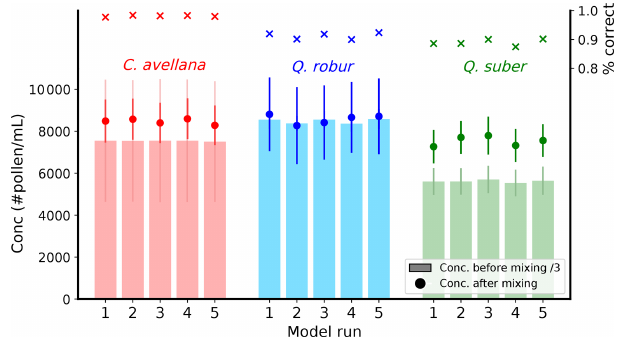
Figure 6. Quantification of pollen concentrations in single-type samples and in a mixed sample. The model was deployed to clas- sify and quantify pollen concentrations in three samples contain- ing purely C. avellana (red), Q. robur (blue), and Q. suber (green) pollen. The percentages of correct predictions among the three pollen classes are indicated in the top right axis as a function of five independent model runs. One-third of the sample pollen con- centrations (as averages of 5, 3, and 10 aliquots, respectively, for C. avellana , Q. robur , and Q. suber ) are indicated as histogram bars, along with 1 σ error bars displayed with light colors. The model was also used to classify and quantify pollen in a 1 : 1 : 1 mix of the original samples (dots and solid colored error bars reflect the average values and 1 σ of 10